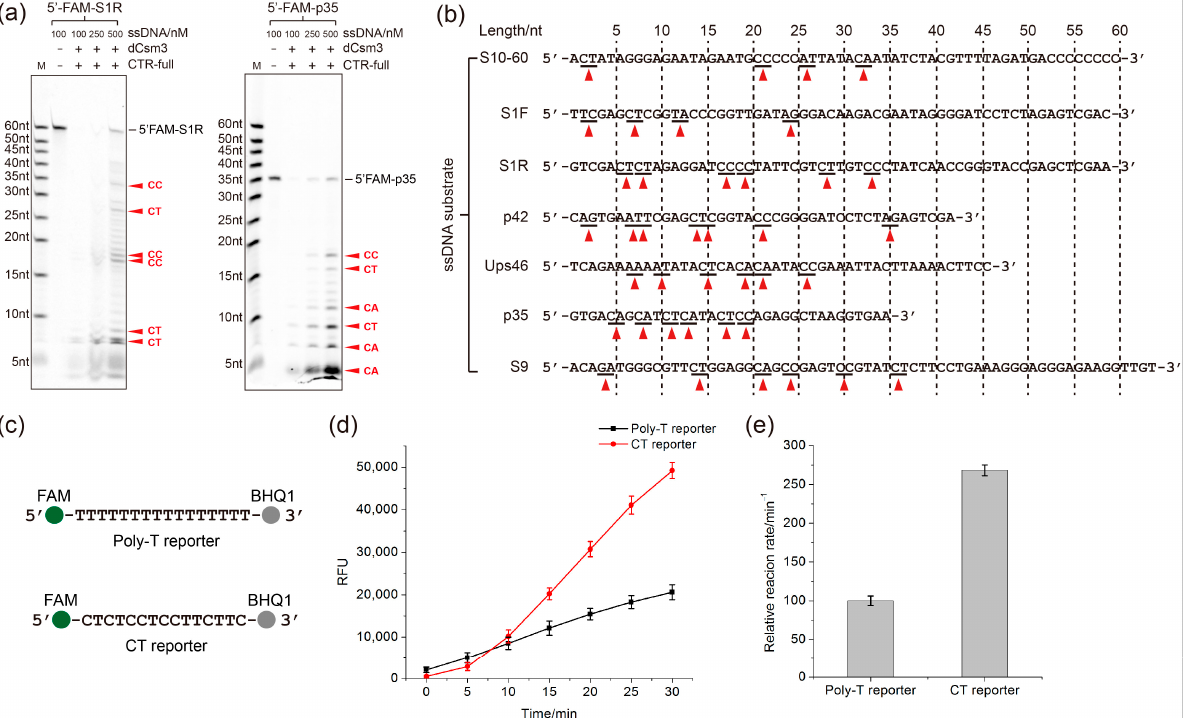
Figure 3. Determination of the nucleotide preference of the LdCsm DNase and testing of the optimized ssDNA reporter. ( a ) PAGE analyses of the preference of DNA cleavage by the LdCsm-dCsm3 DNase. Two ssDNA substrates were incubated with LdCsm-dCsm3, and cleavage products were analyzed by the denaturing PAGE. Bands of main cleavage products are indicated by red triangles. Names of the main dinucleotide cleavage sites are shown on the right of the cleaved products. ( b ) Summary of LdCsm cleavage sites on seven ssDNA substrates revealed from the denaturing PAGE, which are indicated by red triangles underneath their sequences. The sites predicted to be preferred by LdCsm-dCsm3 DNase are labeled by red triangles. ( c ) Schematic of Poly-T reporter and the CT reporter. ( d ) RNA detection reaction by the LdCsm-dCsm3 system using each DNA reporter. ( e ) Relative detection efficiency converted from the data in ( d ) in which the activity with Poly-T reporter was set as